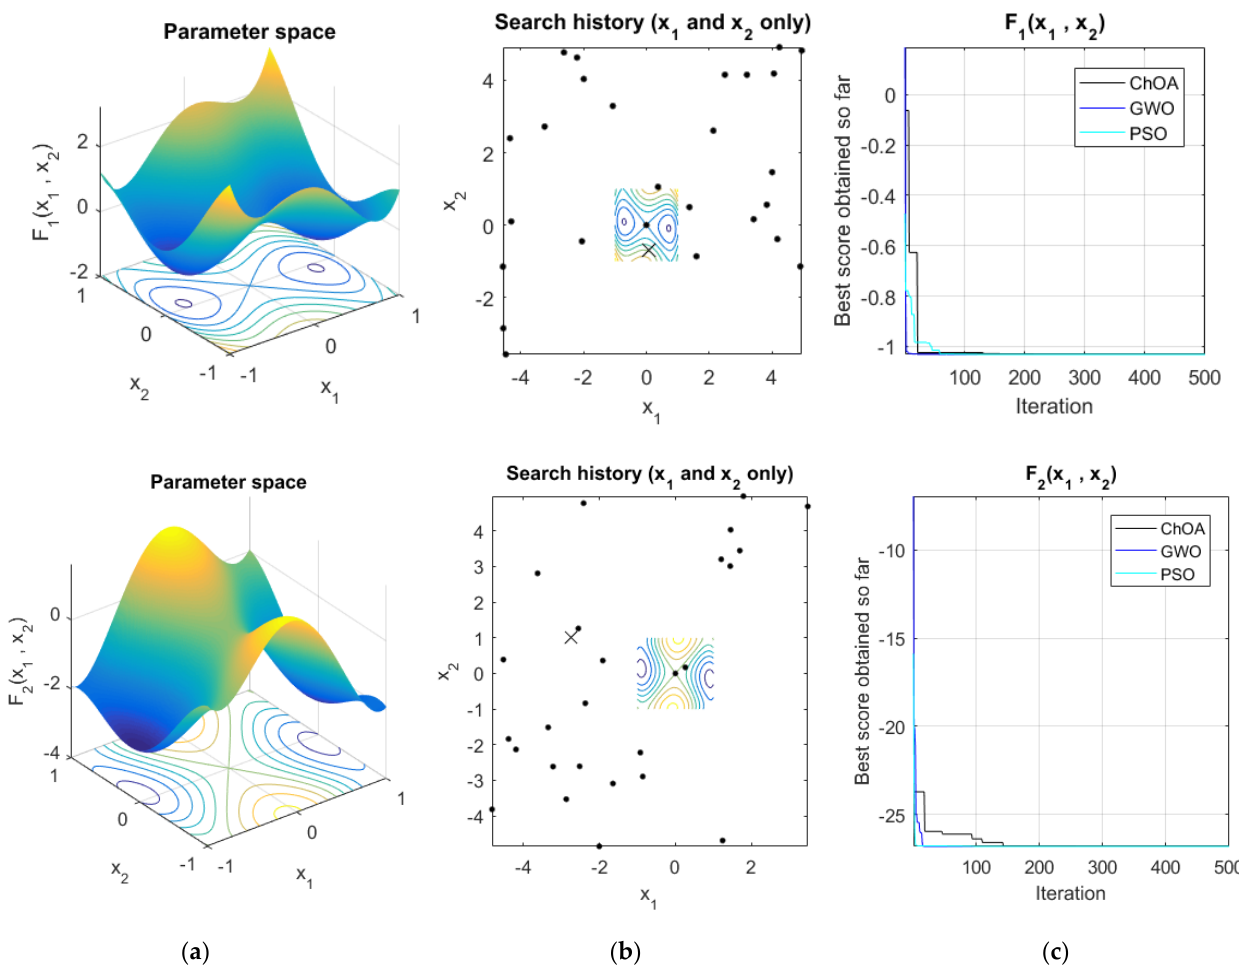
Figure 6. ( a ) 2D function plot of F1, F2 ( b ) Search history of Chimps ( c ) Convergence characteristics of ChOA, GWO, and PSO techniques for the considered fixed dimension test function.